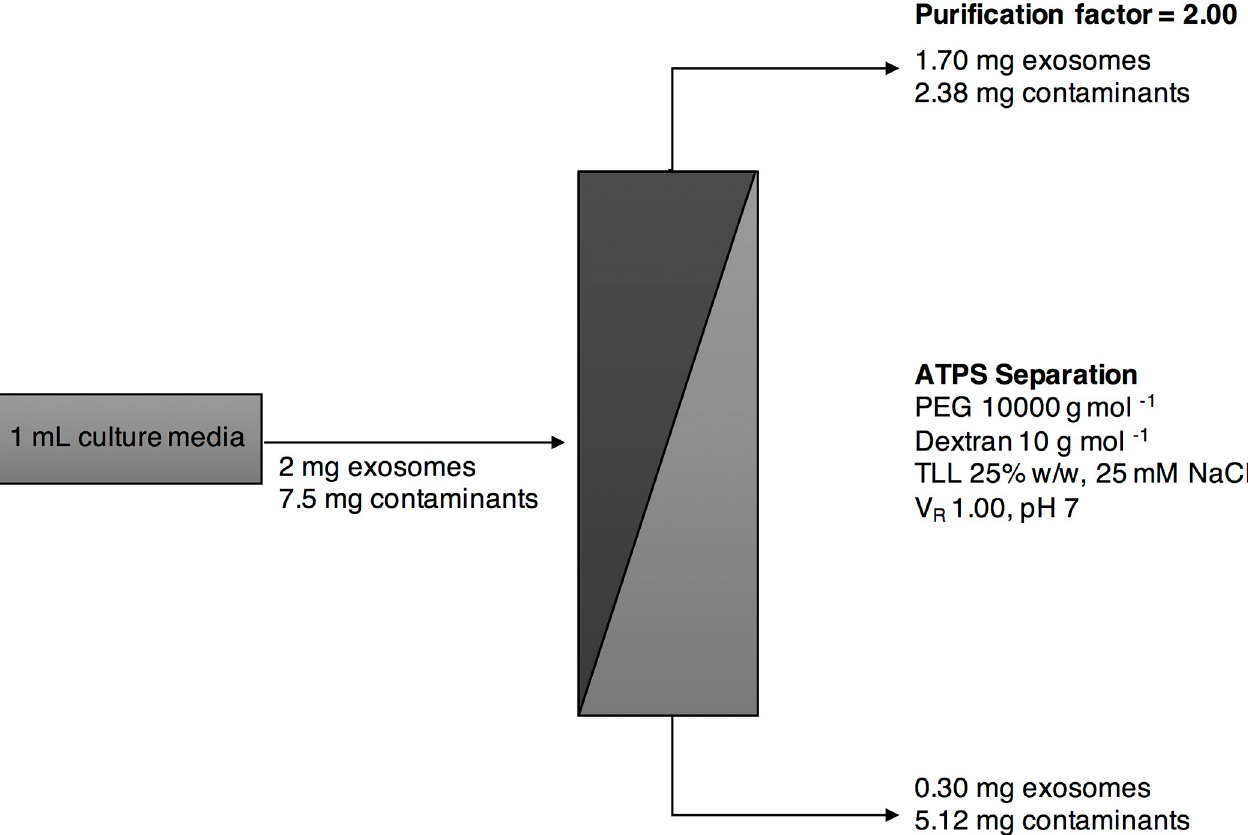
Fig 4. Simplified scheme for the optimized ATPS strategy to selectively fractionate a complex sample. The proposed strategy suggests that after the optimization of the system PEG MW 10000 g/mol—DEXTRAN MW 10000 g/mol, TLL 25% w/w, VR 1.00, pH 7, this ATPS could separate the culture media containing exosomes and contaminants at opposite phases. The recovery yields shown are theoretical according to the previous reported results in this work.